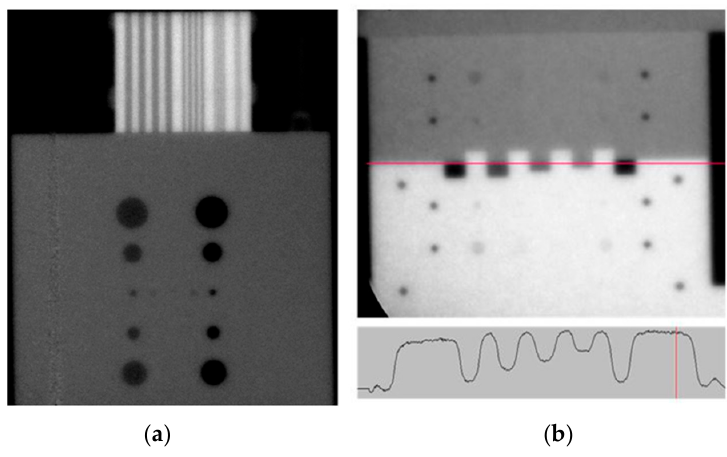
Figure 19. ( a ) Images of a tantalum and polyethylene line pair gauge about 3 cm thick and 3 cm tall is on top of a polyethylene phantom with holes and partial holes; ( b ) A steel and polyethylene phantom with “teeth” and holes. The intensities at the location of the red horizontal line through the center is shown below the image at right.